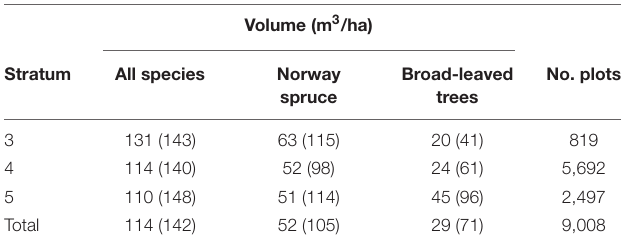
Table 2 . The first dataset consisted of all 72 variables in the